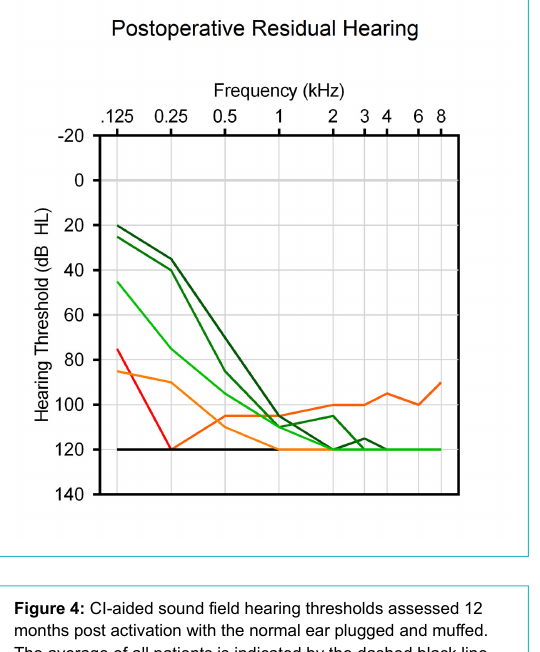
Figure 3: Pure-tone air conduction thresholds of the deaf ear mea- sured with insert earphones 12 months after activation. The curves marked in different shades of green represent hearing thresholds of the patients with preserved residual hearing; the orange curves, the averaged hearing thresholds of patients with partially pre- served residual hearing; the red curve, the hearing thresholds of the single patient with almost complete loss of residual hearing.